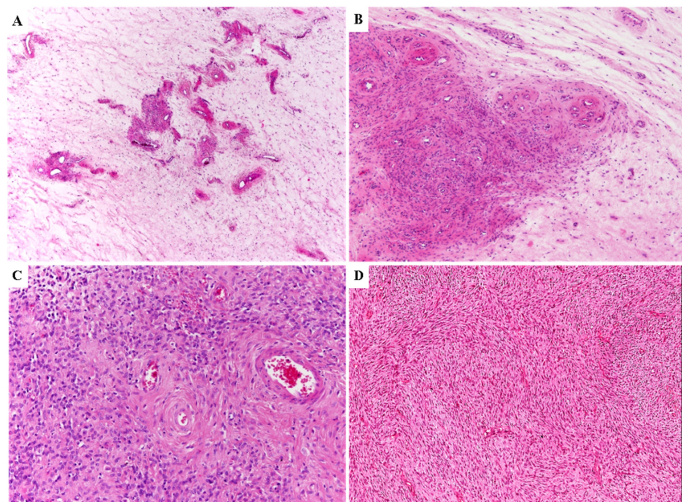
Figure 5. Hypercellularity in 4 different primary DAMs . ( A , B ) Hypercellularity is restricted to vascular regions or it has diffuse extension throughout the tumor ( C , D ). ( D ) In one tumor, neoplastic cells with fibroblastic-like morphology exhibited fascicular arrangement; notice the prominent vas- cular component. In (iii) four cases, perivascular hyalinization was observed (Figure 6A); as an addi- tional finding, the perivascular cuffing of elongated neoplastic spindled cells (onion-skin arrangement) was identified in two cases (Figure 6B); fibro-sclerotic obliteration of the vascular lumens was observed in only in one case (Figure 6C);